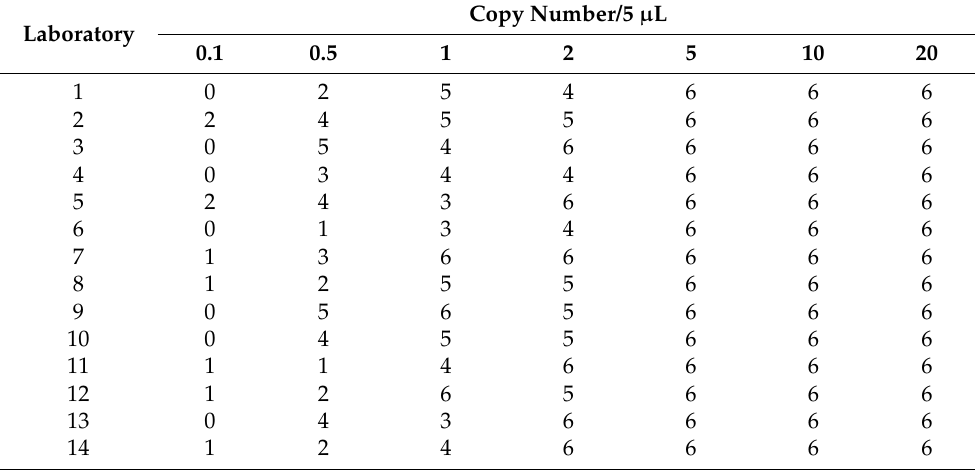
Table 4. Laboratory-specific number of positive results obtained for the DNA isolate from roe deer meat, diluted to 20 to 0.1 copies of the roe deer-specific target sequence per 5 µ L. A result was considered positive in cases in which the Ct value was <45 and the copy number, calculated based on the standard curve, was >0.